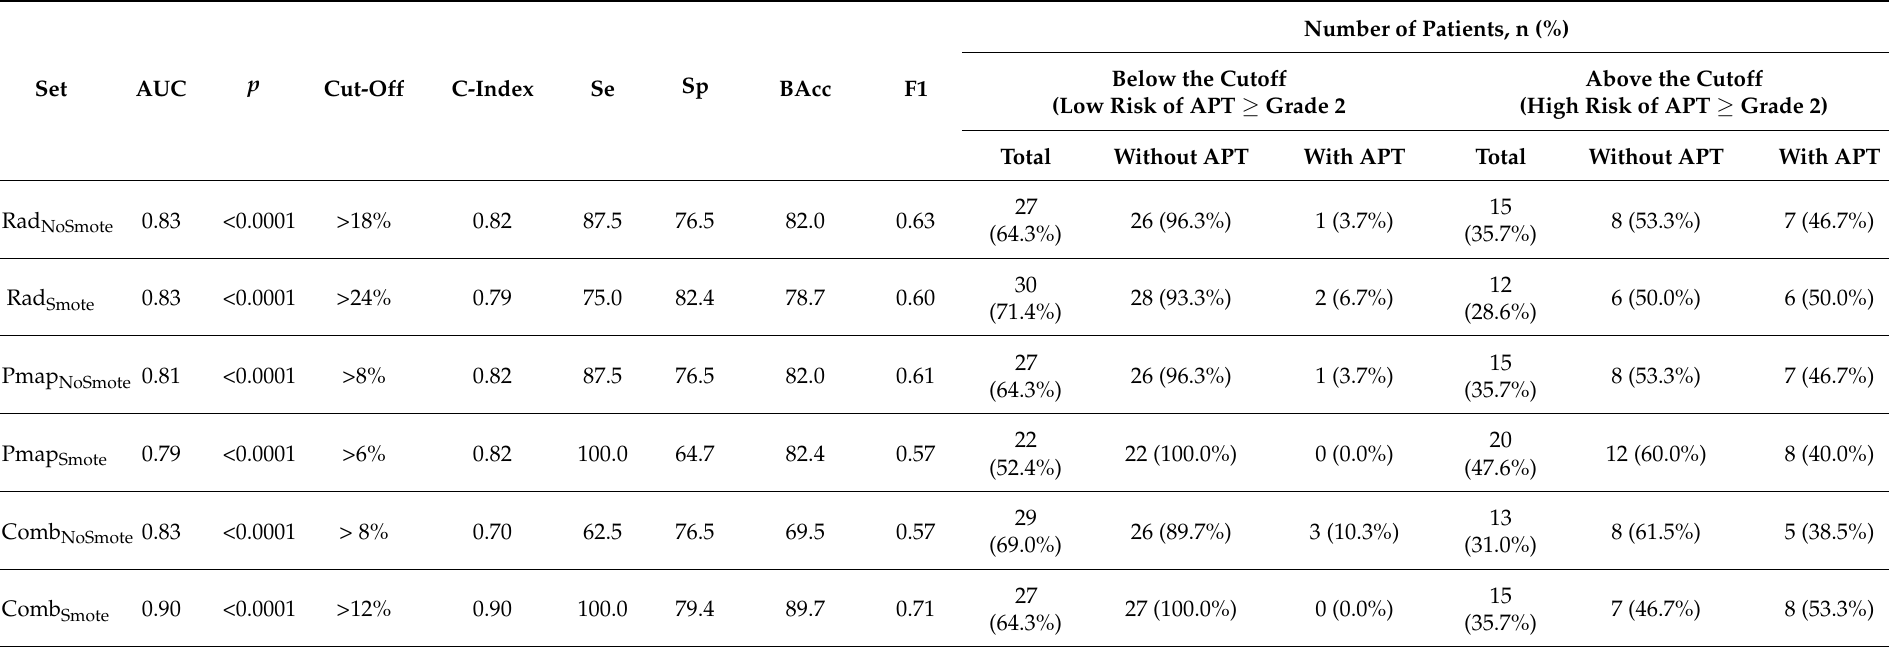
Table 2. Analysis of each model’s discrimination between patients with or without APT ≥ grade 2 in the testing